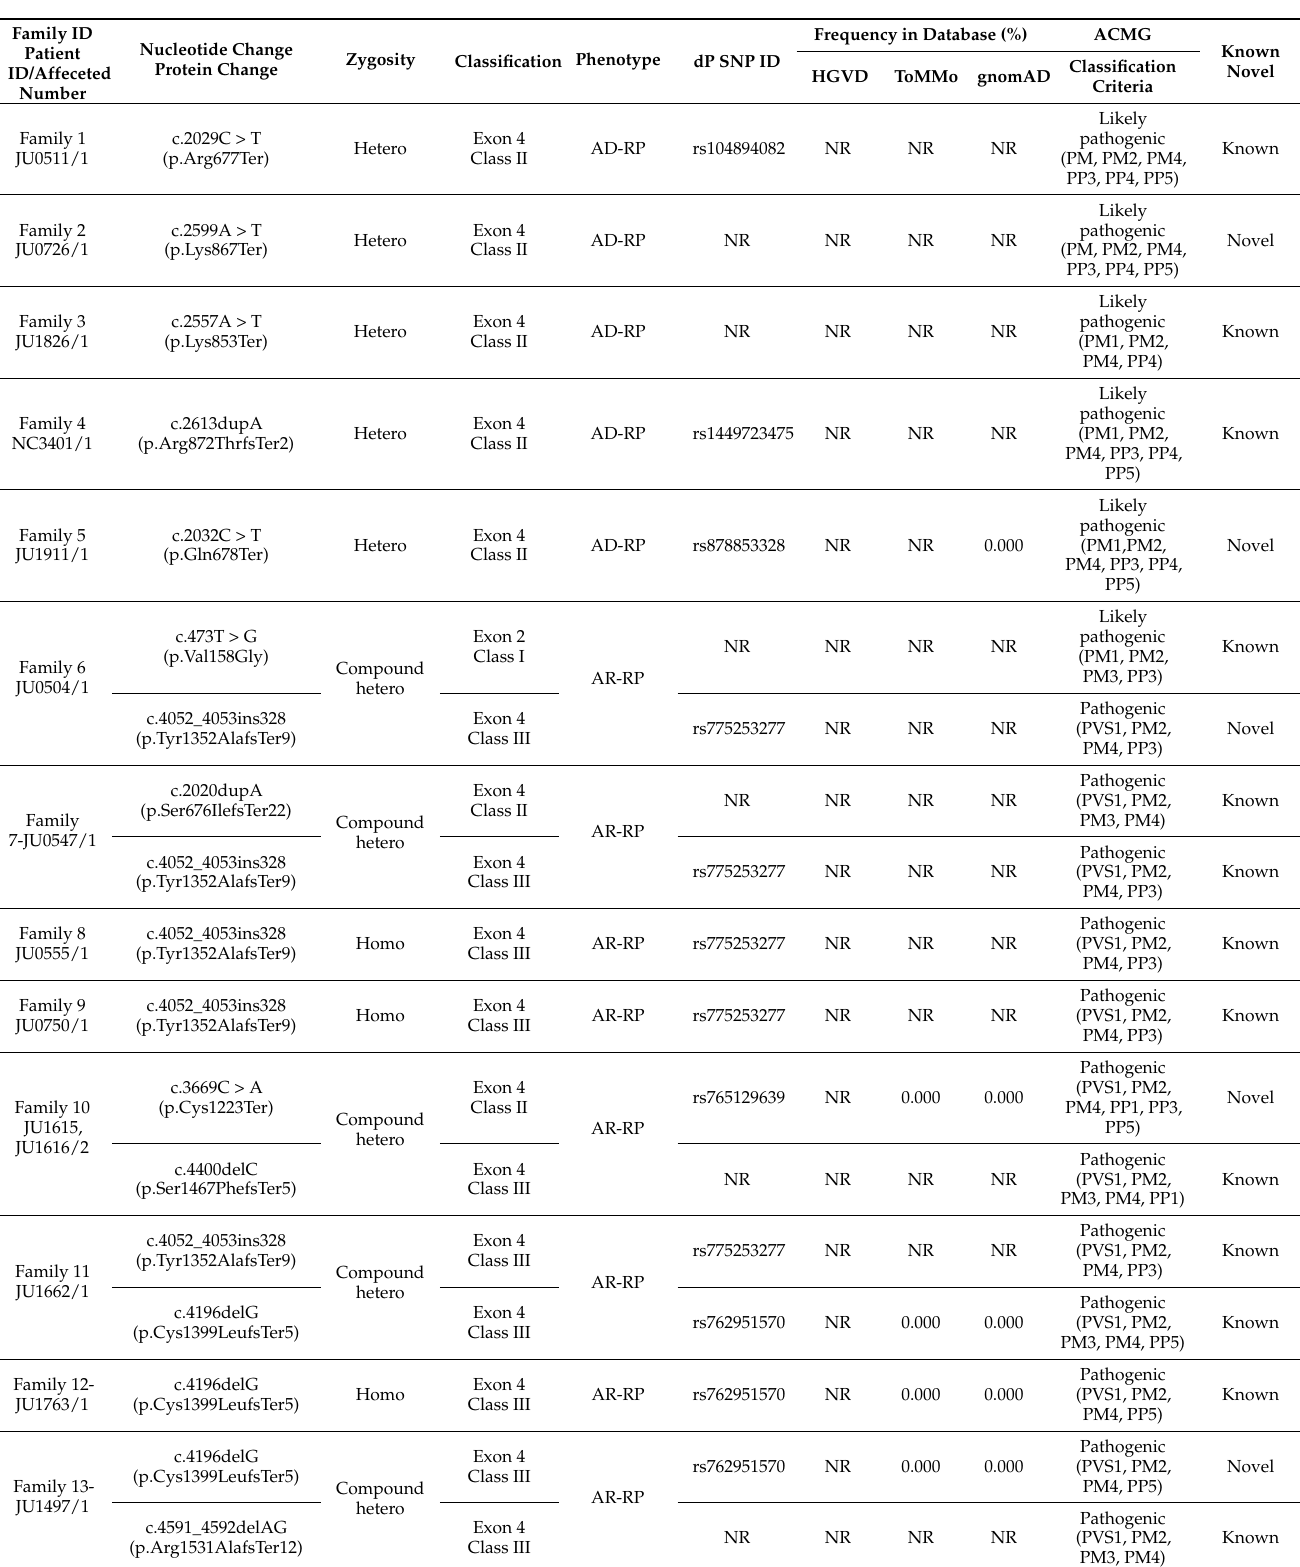
Table 1. Genetic findings of 23 Japanese families with pathogenic RP1 variants and 13 families with non-pathogenic RP1